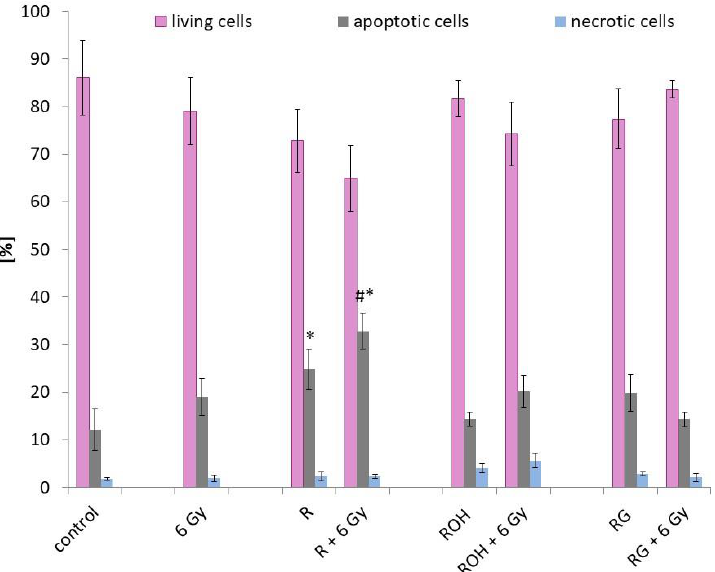
Figure 4. Apoptosis in MCF-7 cells treated with 25 µ M of resveratrol (R), piceatannol (ROH), and piceid (RG) alone and in combination with IR (dose of 6 Gy). Annexin V and propidium iodide staining in MCF-7 cells incubated with stilbene and/or IR for 24 h. Data are shown as the mean ± SD of three independent repetitions. Treatments were compared by a two-way analysis of variance (ANOVA) followed by Tukey’s post hoc test ( p < 0.05). The mean difference (*) was compared with the control and (#) with IR.